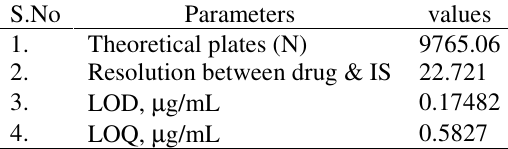
Table 5. System suitability